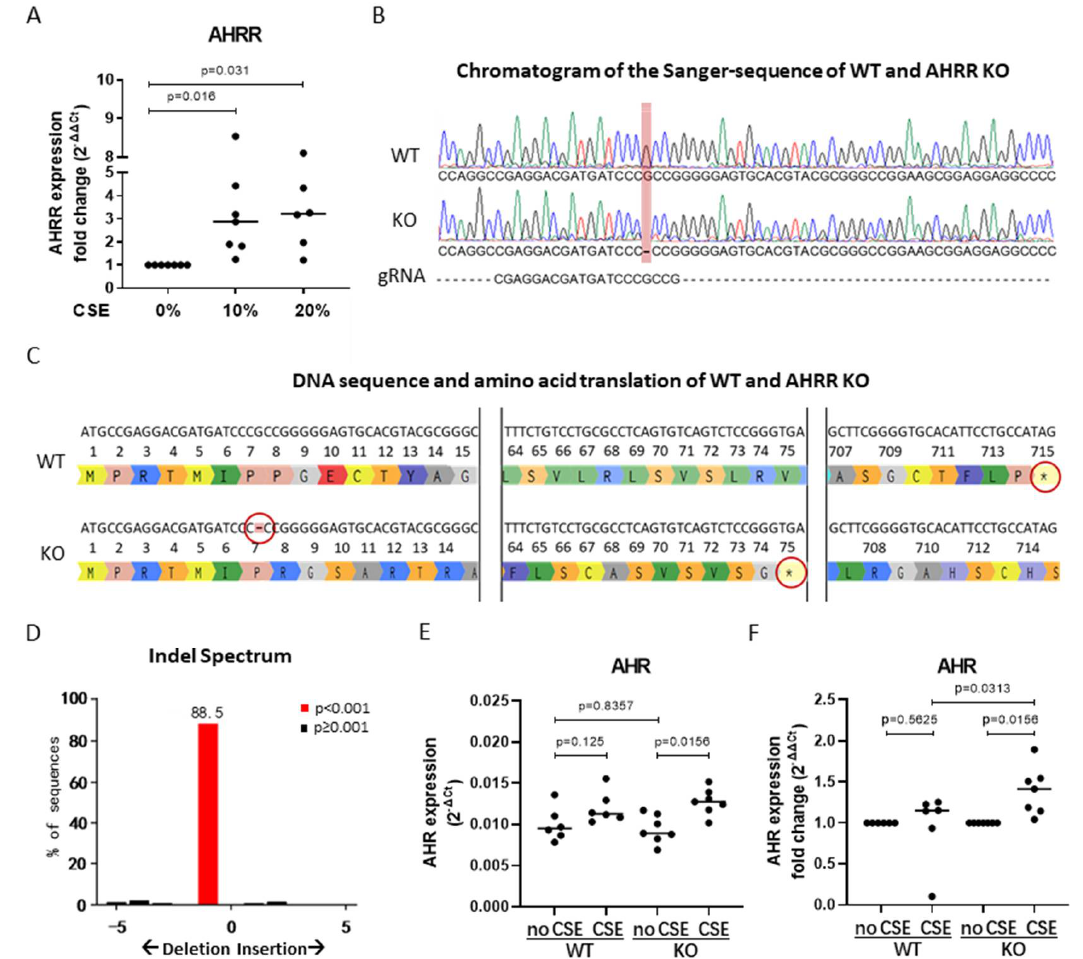
Figure 3. Induction of AHRR mRNA expression in 16HBE cells upon CSE exposure and validation of the AHRR CRISPR/Cas9 knockout. 16HBE cells ( n = 7) were seeded in duplicate, grown to confluence, serum deprived overnight and exposed to 10% and 20% CSE or medium control for 6 h. Cells were harvested for RNA isolation. mRNA Expression of AHRR was measured by qPCR, related to the expression of housekeeping genes B2M and PPIA and expressed as 2 − ∆∆ Ct ( A ). AHRR knockout (KO) cells were generated using CRISPR/Cas9 together with 16HBE wild-type (WT) cells and assessed by Sanger sequencing. The base pair deletion is visualized by the chromatograms of the Sanger-sequenced 16HBE WT and AHRR KO cells as well as the sequence of the guide RNA (gRNA) ( B ). DNA sequence and amino acid translation of WT and AHRR KO in which the base pair deletion in the AHRR KO is indicated by a hyphen and a red circle. Stop codons are indicated by an asterisk and highlighted by red circles ( C ). Indel spectrum produced by Tracking of Indels by Decomposition (TIDE) analysis shows the base pair deletion ( D ). 16HBE WT or AHRR KO cells ( n = 6/group) were seeded in duplicate, serum deprived overnight and exposed to 10% and 20% CSE or medium control (no CSE) for 6 h. Cells were harvested for RNA isolation AHR mRNA expression was measured by qPCR, related to the expression of housekeeping genes B2M and PPIA and expressed as 2 − ∆∆ Ct ( E ) or fold change (2 − ∆∆ Ct ) with the CSE groups normalized to their medium controls ( F ). Median levels are indicated. Differences between treatment conditions were tested with the Wilcoxon rank-sum test and the difference between WT and AHRR KO at baseline was tested with Mann–Whitney test. p -values are as indicated between the groups.